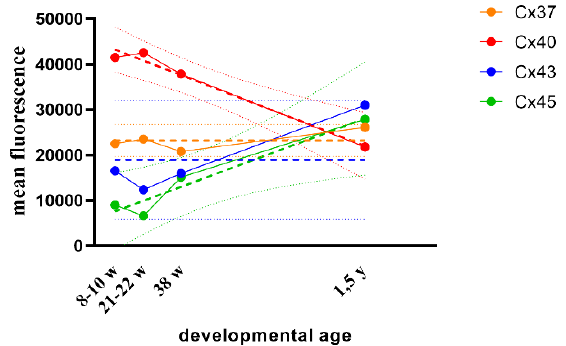
Figure 1. Scatter plot with error bars (95% CI) showing differences in the course of Cx37, Cx40, Cx43 and Cx45 expression during human kidney development.